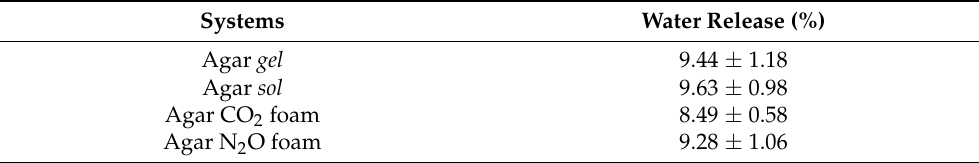
Table 1. Percentage water release for the four different agar systems.